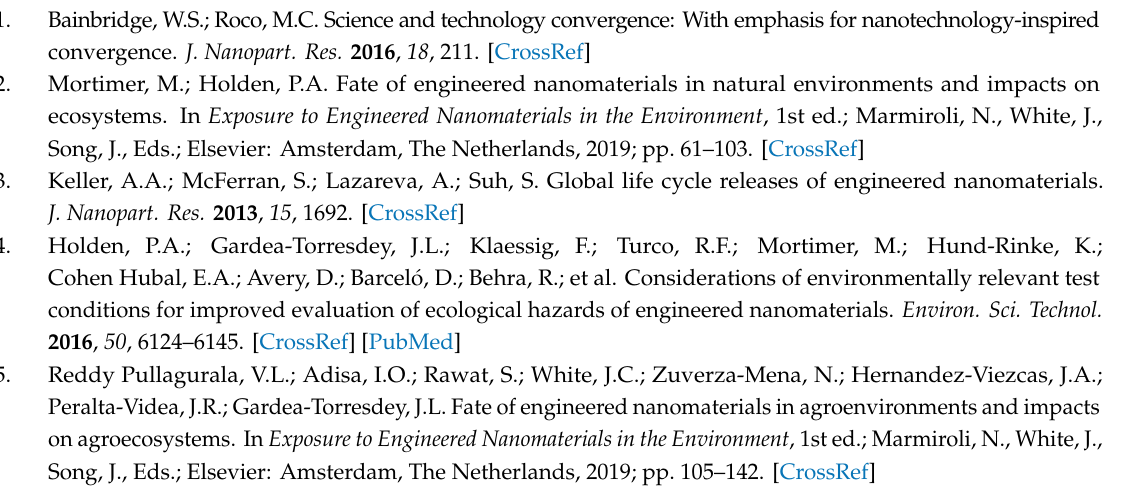
Table S1: Theoretical ratio calculated at a hypothetical equal mass of nanoparticles uptaken by plants exposed to nCeO 2 25 nm and 50 nm. The ratio is calculated by dividing the number of n CeO 2 25 nm by the number of n CeO 2 50 nm; both numbers are calculated dividing the mass by the estimated the mass of a single nanoparticle (g / g). Table S2: The observed ratio calculated at the measured mean Ce uptake by the plants exposed to the two n CeO 2 25 nm and 50 nm for the treatments 200 and 2000 ppm and the two species L. flos-cuculi and D. tenuifolia . The ratio is calculated by dividing the number of n CeO 2 25 nm by the number of n CeO 2 50 nm; both numbers are calculated dividing the mass of Ce derived from the measured mean Ce by the estimated the mass of a single nanoparticle (g /